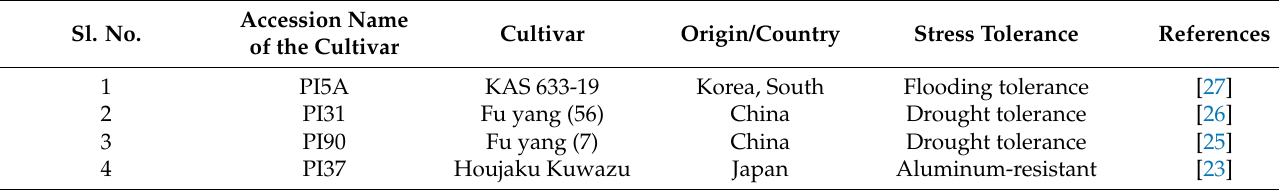
Table 1. Details of soybean cultivars used in the